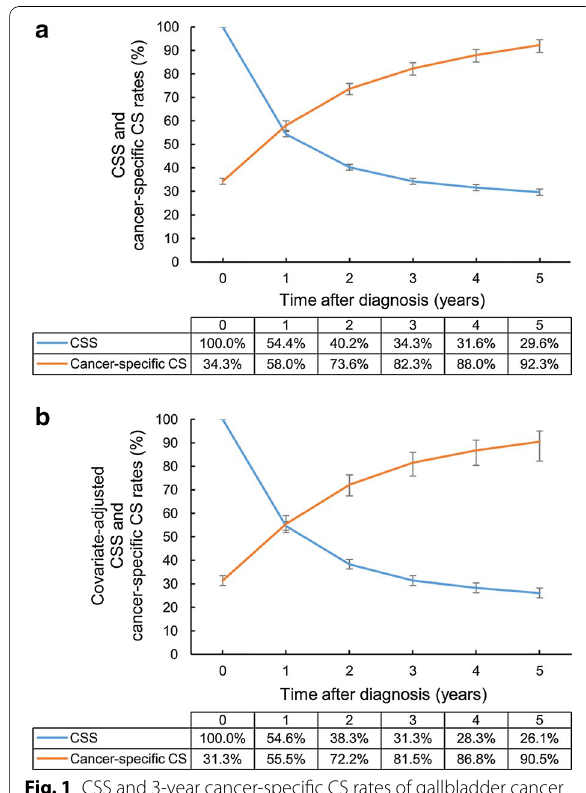
Fig. 1 CSS and 3‑year cancer‑specific CS rates of gallbladder cancer patients: a unadjusted (Kaplan–Meier) and b covariate‑adjusted (Cox model) CSS and CS rates. Error bars indicate 95% confidence intervals (CIs). CSS cancer‑specific survival, CS conditional